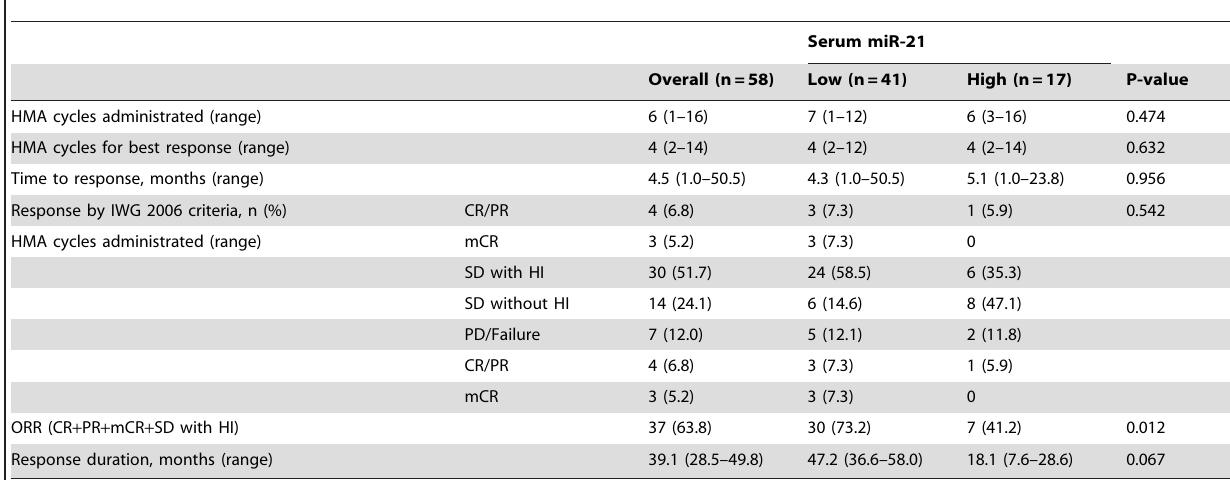
Table 2. Response to HMA therapy according to serum miR-21